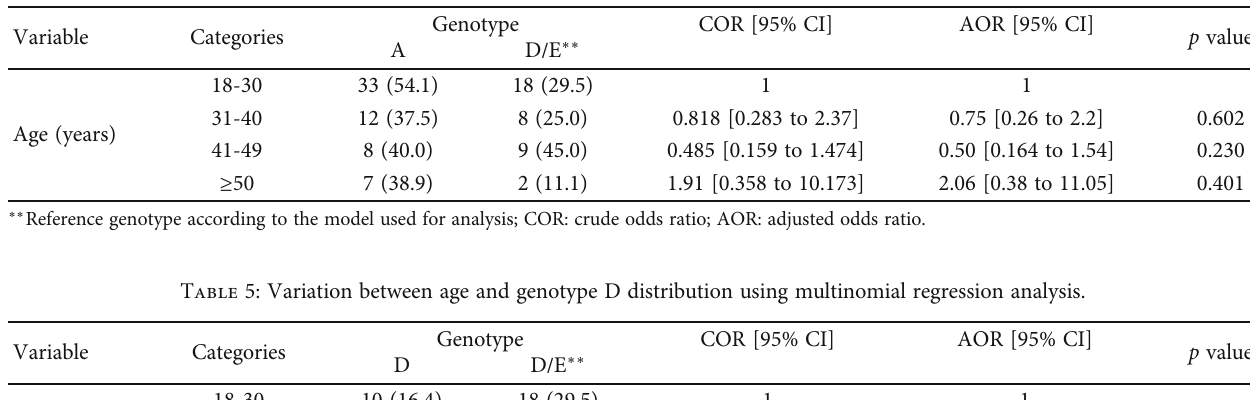
Table 4: Variation between age and genotype A distribution using multinomial regression analysis.